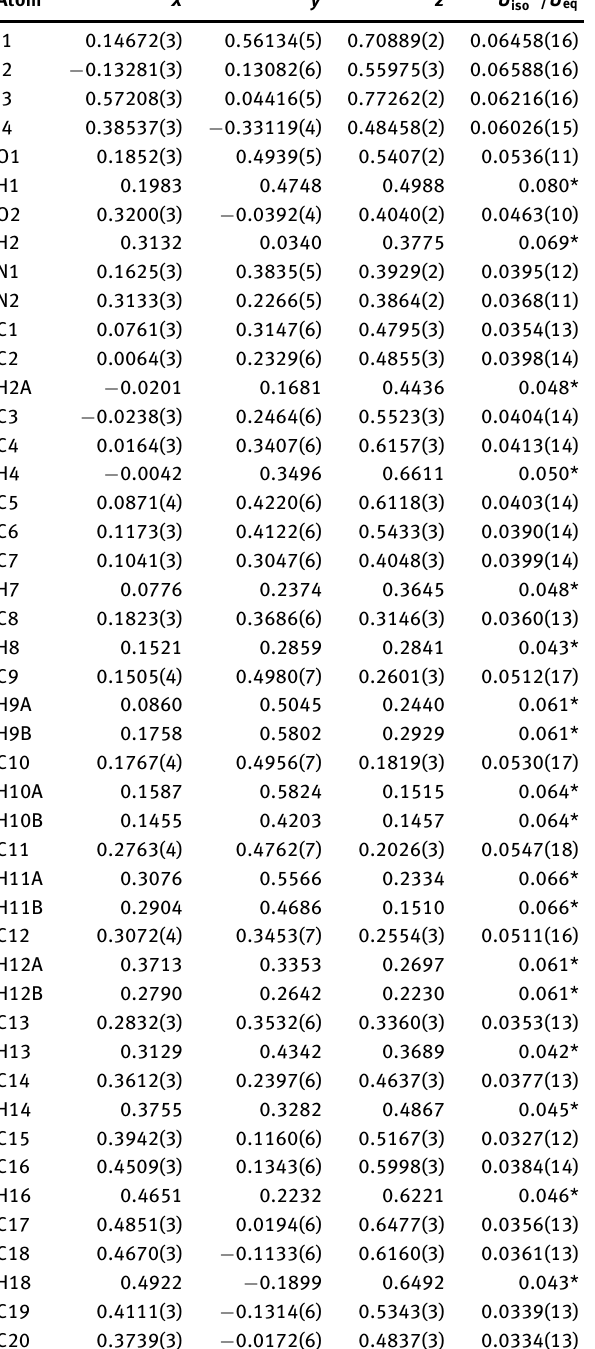
Table 2: Fractional atomic coordinates and isotropic or equivalent isotropic displacement parameters (Å 2